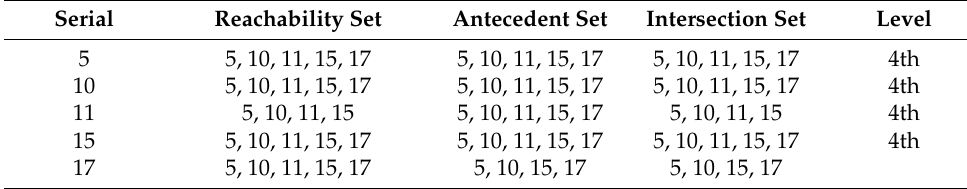
Table A4. Level partitioning (Level 4).